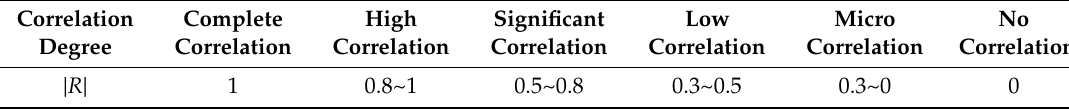
Table 3. Strength of correlation indicated by di ff erent correlation coe ffi cient